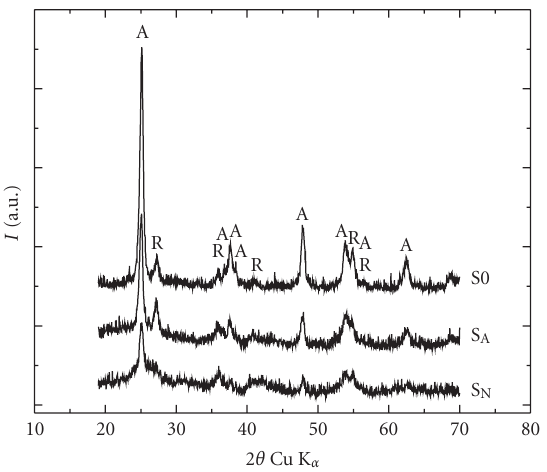
Figure 10: XRD di ff raction patterns for the nanotitania samples S N , S A , and S0, with anatase (A) and rutile (R) peak identification.